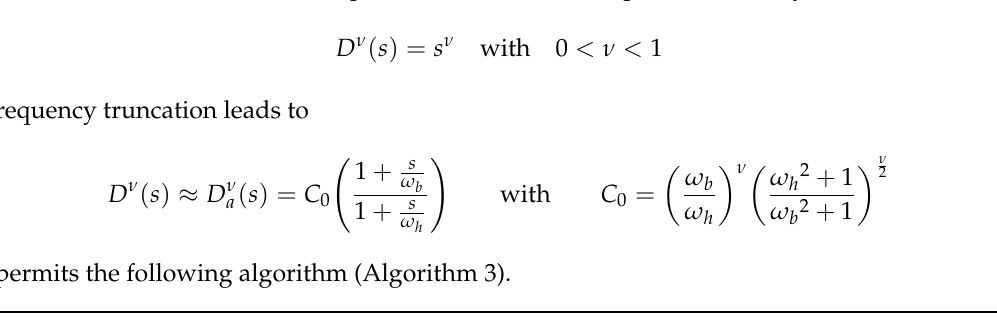
Figure 1. Bode plots comparison of I ν ( s ) , I ν a ( s ) and I ν . Algorithm 2. Fractional integrator approximation—second method